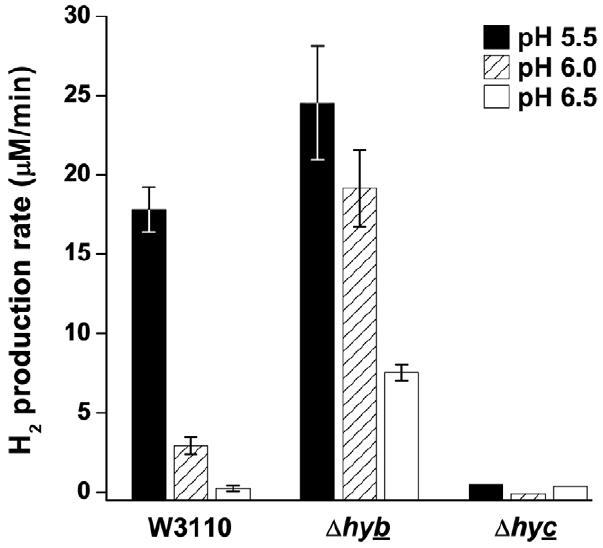
Figure 2. Effect of pH on the H 2 production rate of W3110, D hybC, and D hycE . Anaerobic cultures were grown to log phase at pH 5.5 (black bars), 6 (hatched bars), and 6.5 (white bars) and assayed for H 2 production as described in the Materials and Methods. H 2 production rate was calculated as stated in the Materials and Methods. Error bars represent SEM, n=3; those that were too small to see clearly were omitted. The experiment was conducted twice.